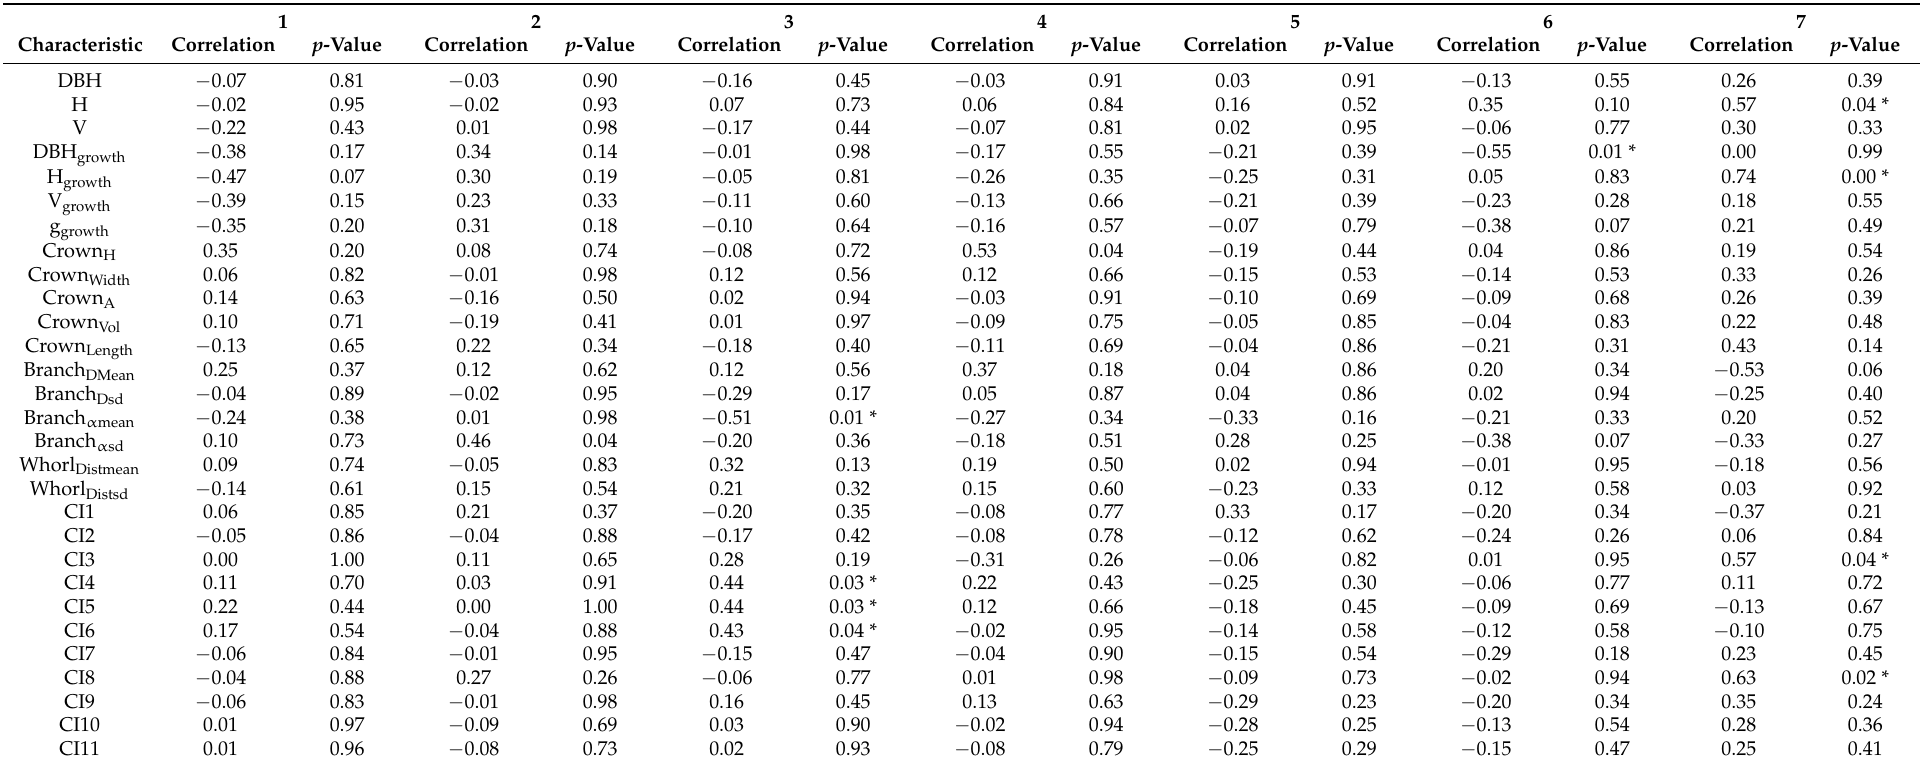
Table A1. Pearson’s correlation coefficients between ring basal area weighted mean wood density (WD g ) and tree structural characteristics (refer to Table 2 for descriptions) within different thinning treatments (i.e., moderate below (1), moderate above (2), moderate systematic (3), intensive below (4), intensive above (5), intensive systematic (6), no treatment (7). Moderate refers to thinning guidelines applied in Finland [43] whereas intensive results in 50% lower remaining basal area (m 2 /ha) compared to moderate thinning. Control refers to plots without thinning treatments since the establishment. * Indicates a statistical significance (i.e., p -value ≤